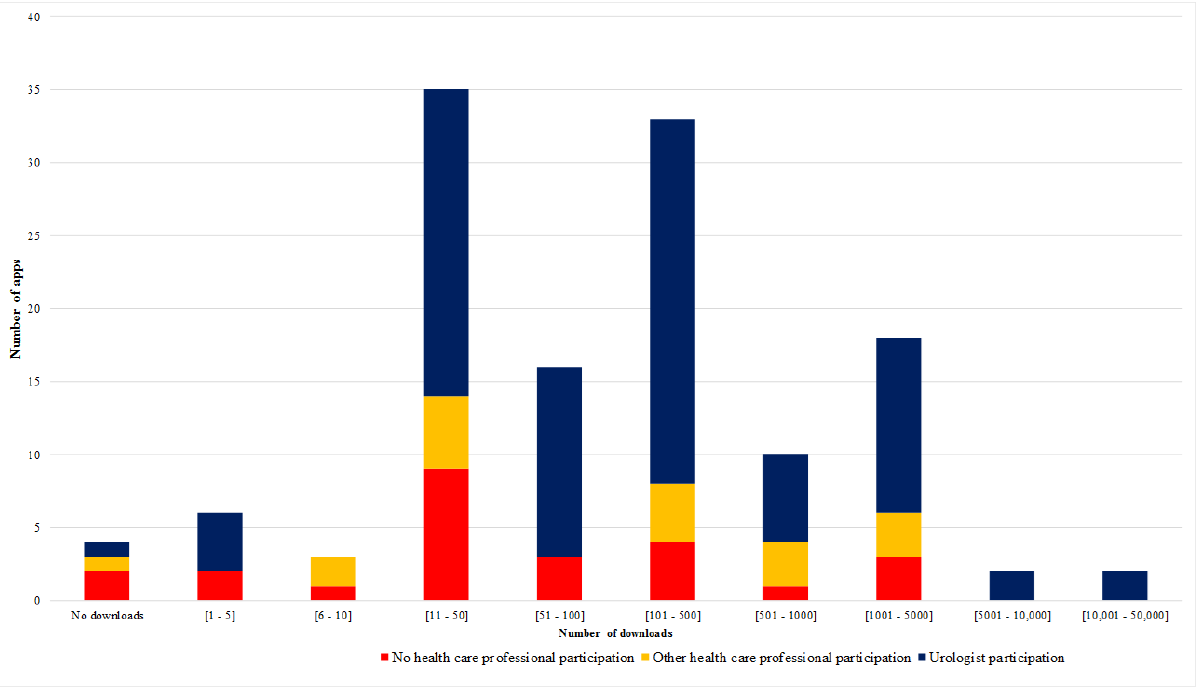
Figure 1. Number of urology apps per level of downloads and health care professional